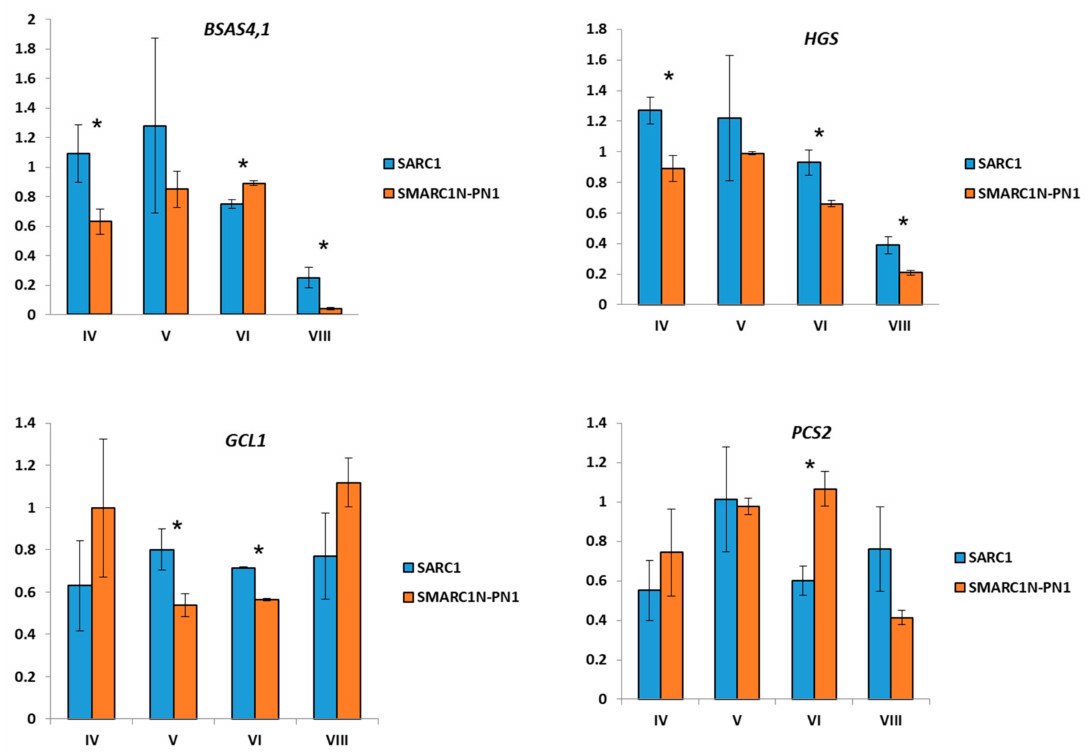
Figure 3. Relative expression of transcripts at di ff erent developmental stages in SARC1 and SMARC1N-PN1 determined by RT-qPCR. Average ± standard deviation. Asterisks indicate significant di ff erences at t-test p value ≤ 0.02. n =